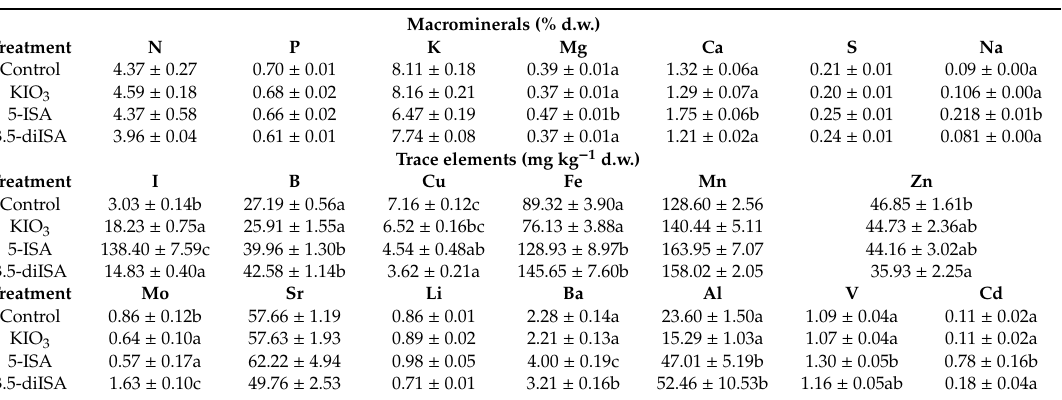
Table 3. Mineral composition (means for